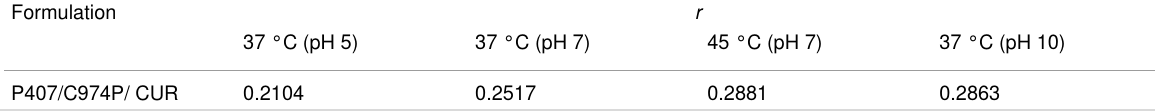
Table 1: Anisotropy ( r ) of formulation containing poloxamer 407 (P407), Carbopol 974P(C974P) and curcumin (CUR) under different conditions of pH and temperature. Formulation